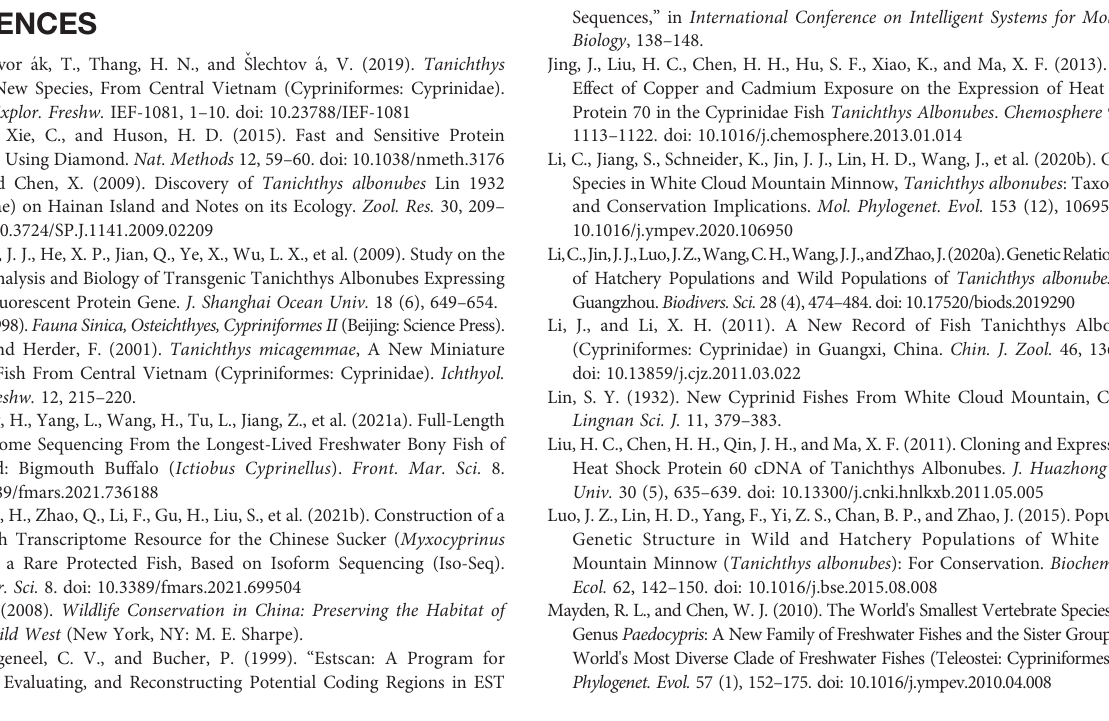
Supplementary Figure 1 | (A) Length distribution of raw reads from PacBio Sequel platform. (B) Length distribution of high-quality FLNC reads. Supplementary Figure 2 | BUSCO assessment results of the White Cloud Mountain minnow full-length transcriptome. Supplementary Figure 3 | Annotation of the White Cloud Mountain minnow full- length transcriptome in three databases. (A) Top ten species distribution annotated inNRdatabase. (B) StatisticsofKOGfunctionclassi fi cation. (C) BarplotofeggNOG function classi fi cation. Supplementary Figure 4 | Sequence length distribution of protein-coding sequences. (A) Sequence length distribution of CDSs based on BLAST method. (B) Sequence length distribution of CDSs based on ESTscan program. Supplementary Figure 5 | Analysis of lnRNA. (A) Venn diagrams of non-coding RNA predicted by four software. (B) Length distribution of lncRNA. (C) GC content frequency distribution. Supplementary Figure 6 | Analysis of Transcription factors (TFs) and TF families. (A) Top ten species distribution of TFs annotated. (B) TFs families distribution. Supplementary Figure 7 | SSR type